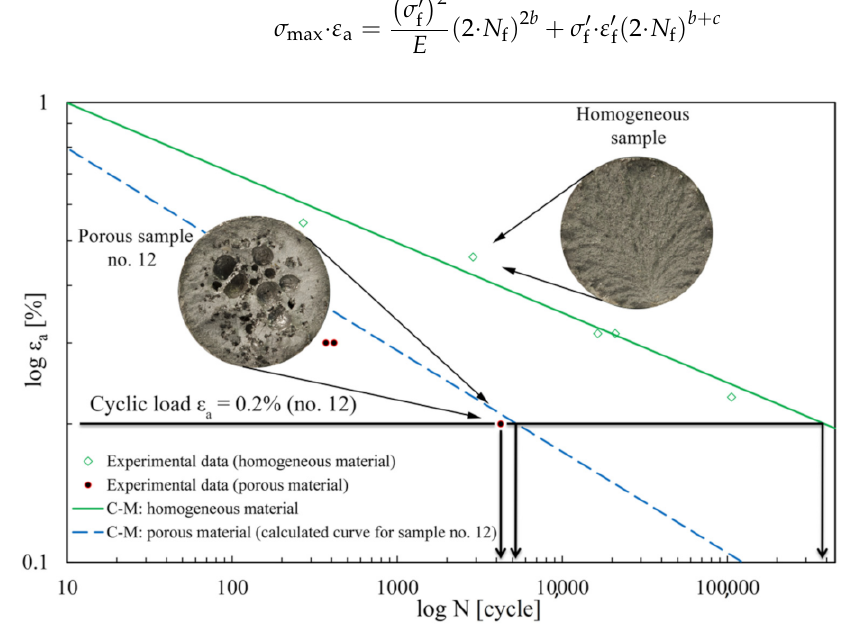
Figure 12. Shift of the calculated C–M curve of AlSi9Cu3 alloy for porous sample no. 12.